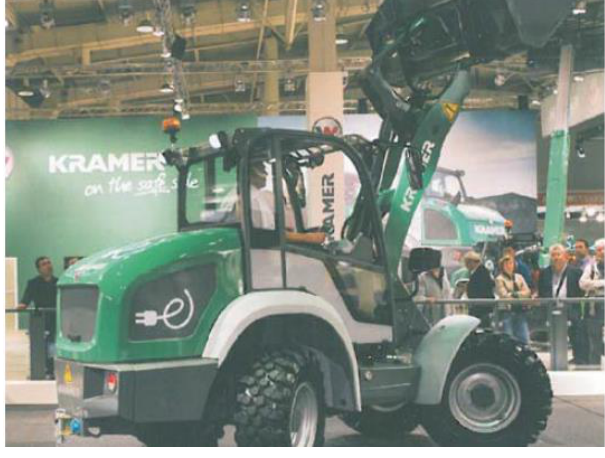
Fig. 24. Kramer 5055e loader [17]